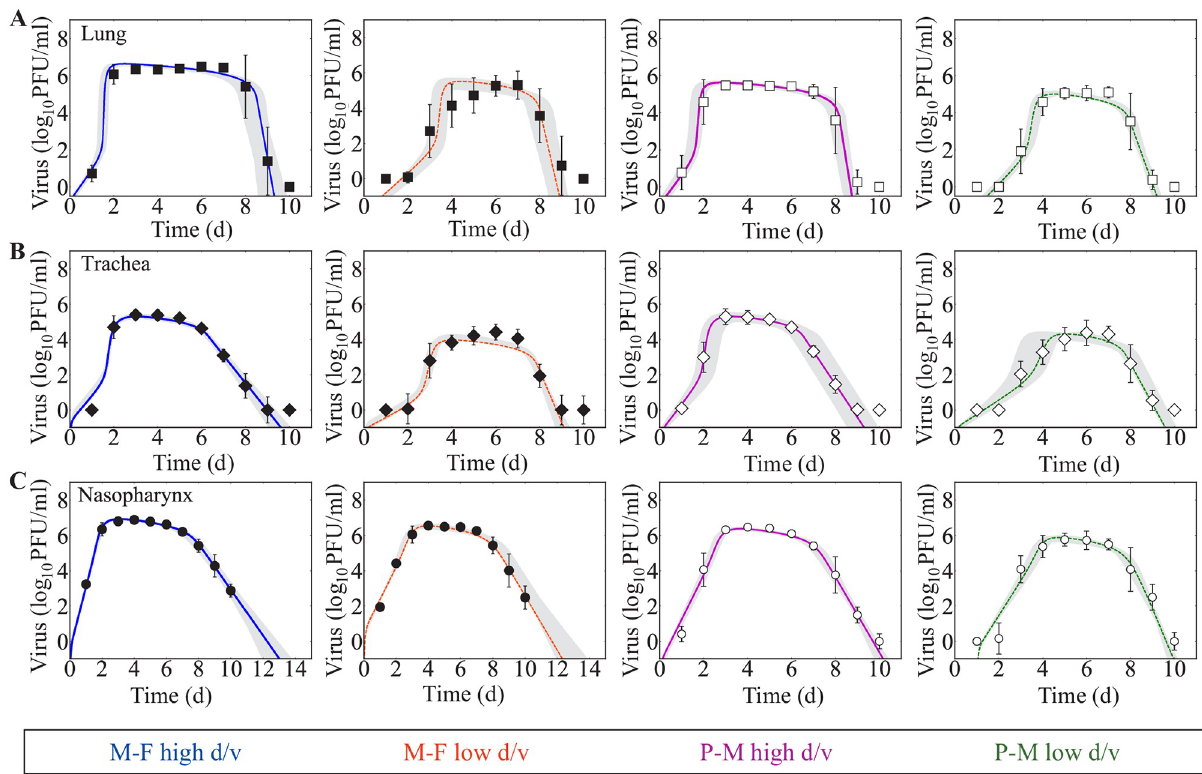
Fig 2. Fit of the viral kinetic model to estimated viral loads from the lung, trachea, and nasopharynx during SeV infection with different strains and doses. (A-C) Fit of the model (Eqs (3)–(6)) to estimated viral loads from the lung (Panel A, squares), trachea (Panel B, diamonds) and nasopharynx (Panel C, circles) of mice infected with rSeV-luc(M-F � ) (“M-F”, black) at high d/v (solid blue line) or low d/v (dashed orange line) or with rSeV-luc (P-M) (“P-M”, white) at high d/v (solid magenta line) or low d/v (dashed green line). The gray regions are the model solutions using parameter sets within the 95% CIs. Data are shown as geometric mean ± standard deviation for 15 mice per